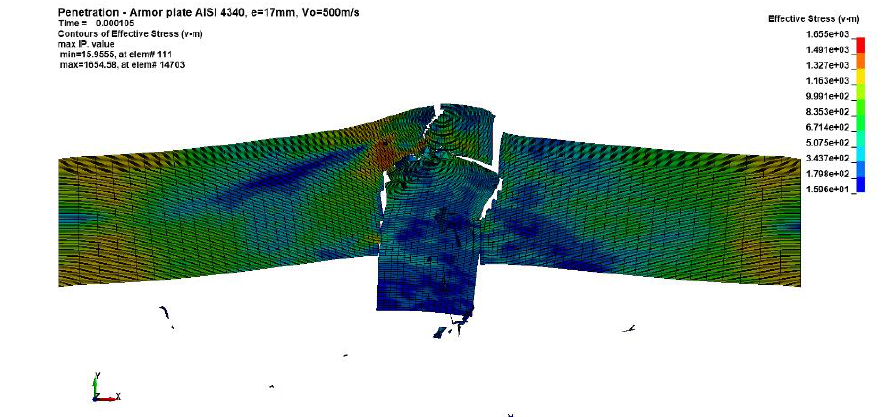
Figure 20 – Von Misses equivalent stress, time of analysis 0.1 ms – Model 3 Рис. 20 – Von Misses эквивалентное напряжение, время анализа 0.1 ms – Модель 3